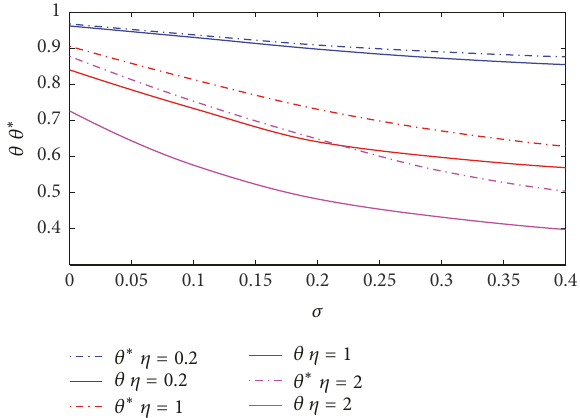
Figure 1: Dependence of 𝜃 ∗ and 𝜃 on 𝜎